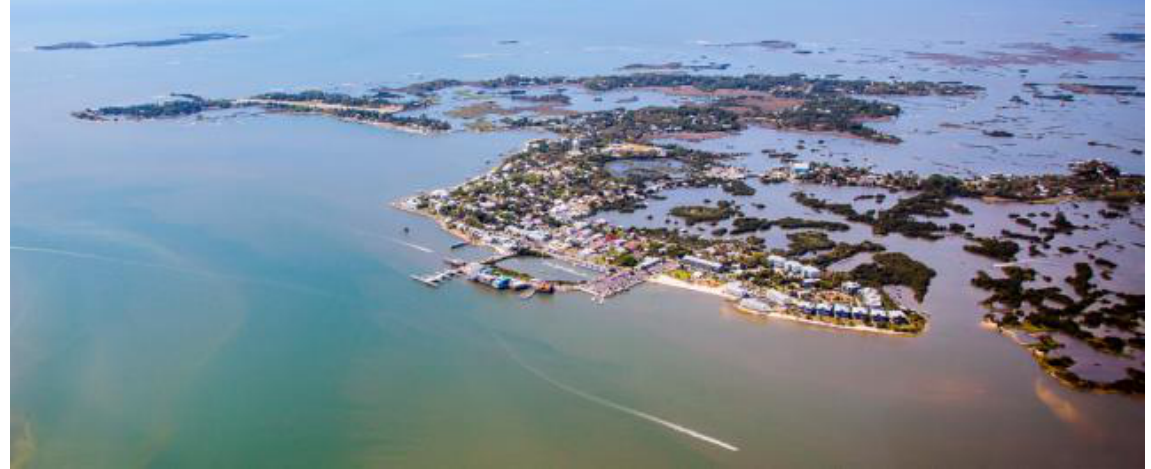
Figure 3. Cedar Key on Florida’s Nature Coast, Levy County. Presented previously in [87].